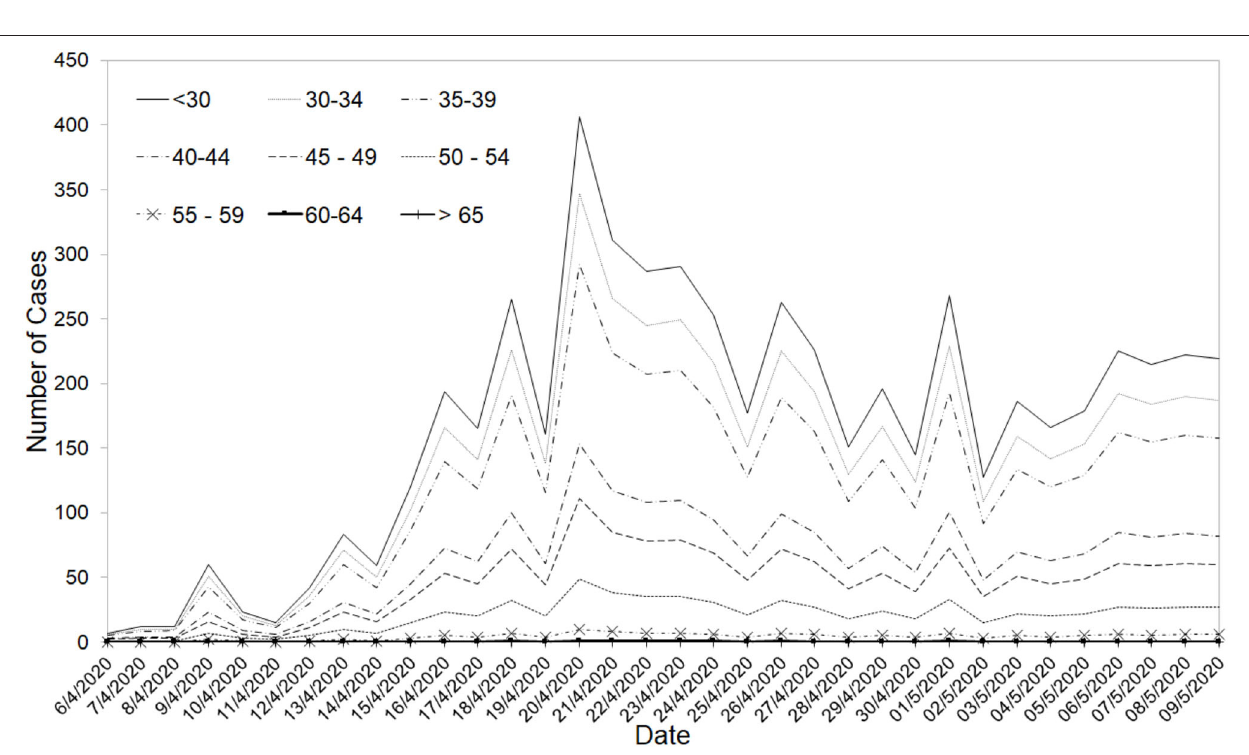
FIGURE 5 | Distribution of the number of cases across age groups for the migrant dormitories’